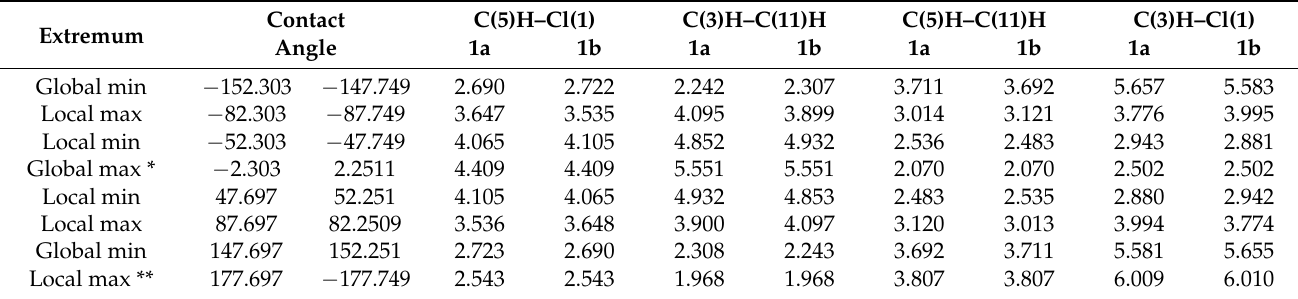
with corresponding models (a comparison of geometrical parameters are listed in Table 3) and correspond to the two global minima in the relative energy curve (Figure 6)